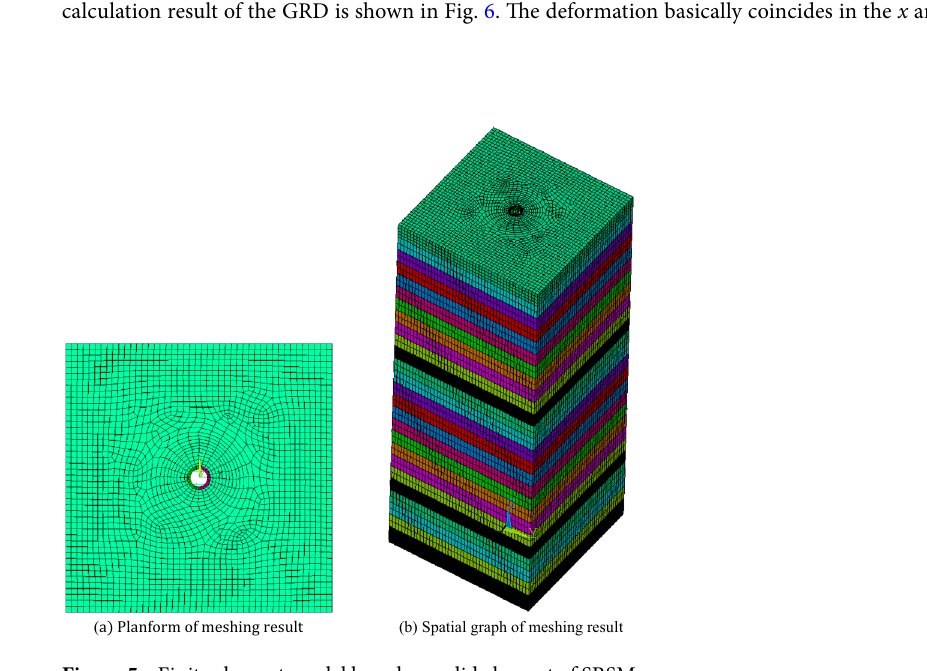
Figure 5. Finite element model based on solid element of